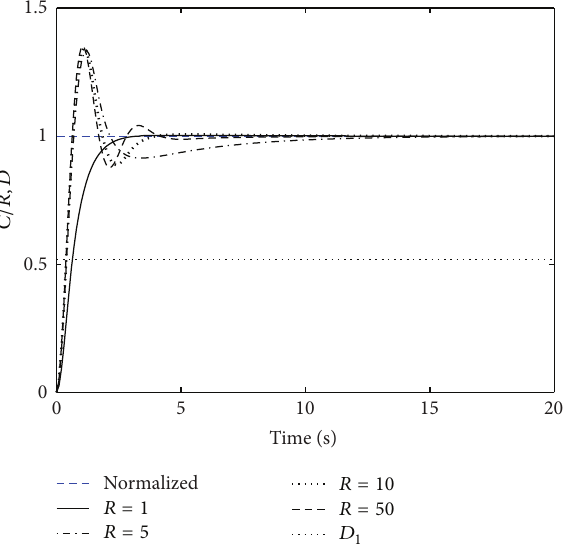
Figure 3: Time responses of the illustrating example for 𝑅 = 1, 5,10 , and 50 and 𝐷 1 = 0.525